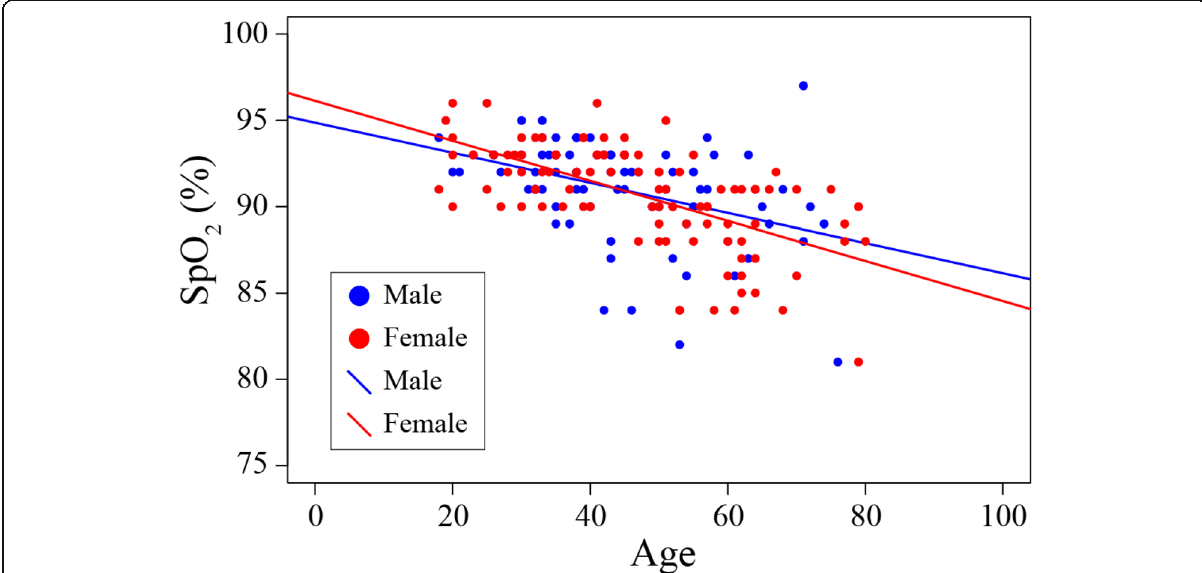
Fig. 4 Relationship between SpO 2 and age in each sex. Age plotted against SpO 2 in participants. Males and females are indicated by blue and red circles, respectively. There was a negative correlation between age and SpO 2 in each sex, and the approximate expressions for males and females were derived as y = − 0.0872 x + 94.868 ( r = − 0.4034193, p = 0.0003021, blue line) and y = − 0.1147 x + 96.136 ( r = − 0.6118297, p = 6.615e − 12, red line), respectively, using Pearson correlation